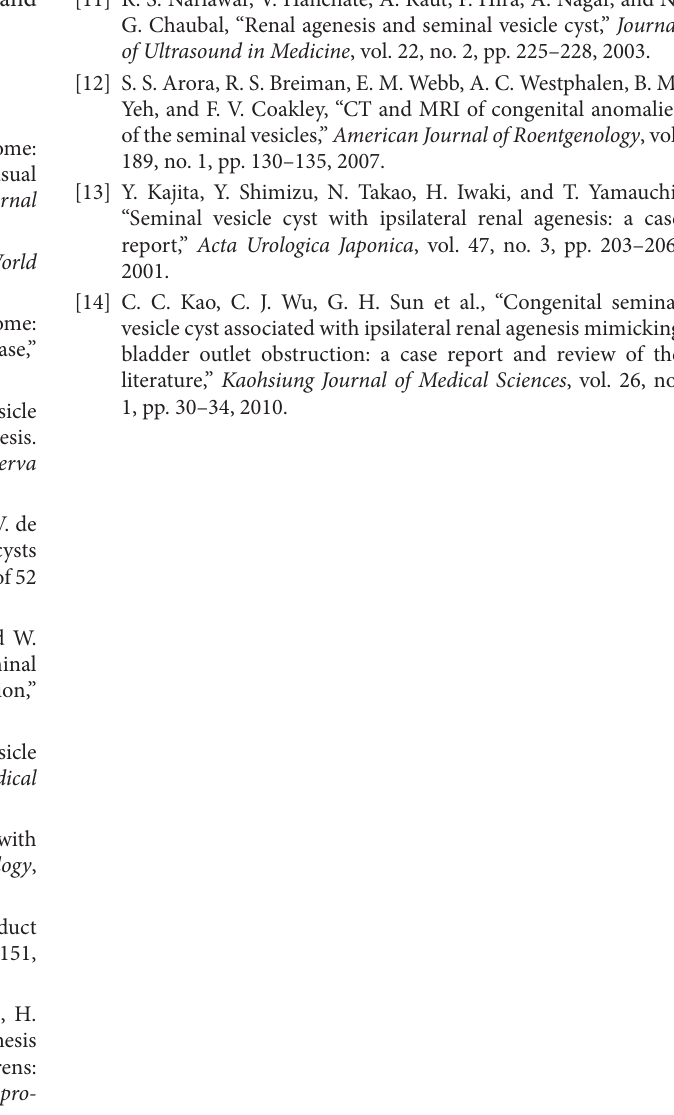
syndrome, and symptomatic cases can be managed safely and effectively using